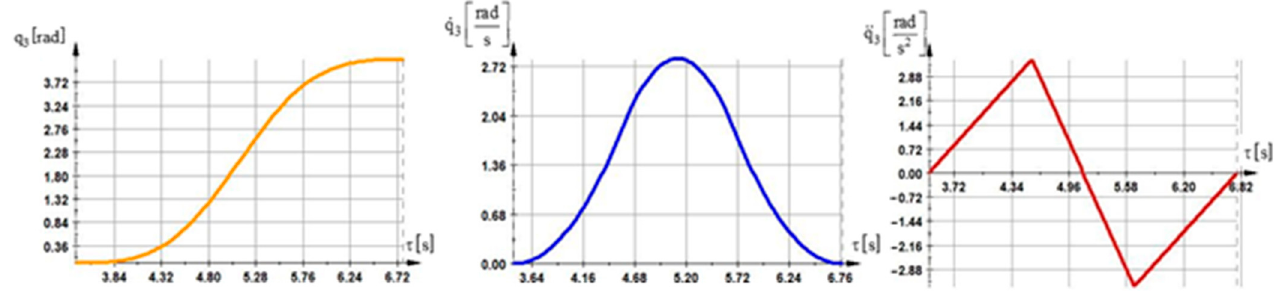
Figure 7. Expressions that vary with time for the generalized coordinates, speeds, and accelerations for kinetic joint j = 3.